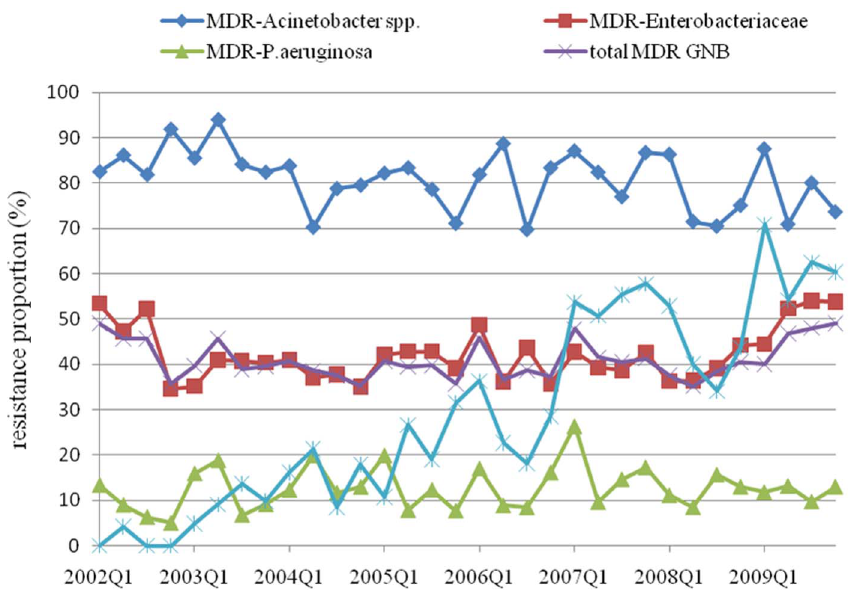
Figure 1. The resistance proportion of healthcare-associated infections caused by multidrug-resistant Gram-negative bacilli from 2002 to 2009. Abbreviations: CR= carbapenems resistant; GNB= Gram-negative bacilli; MDR= multidrug-resistant; Q= quarter.